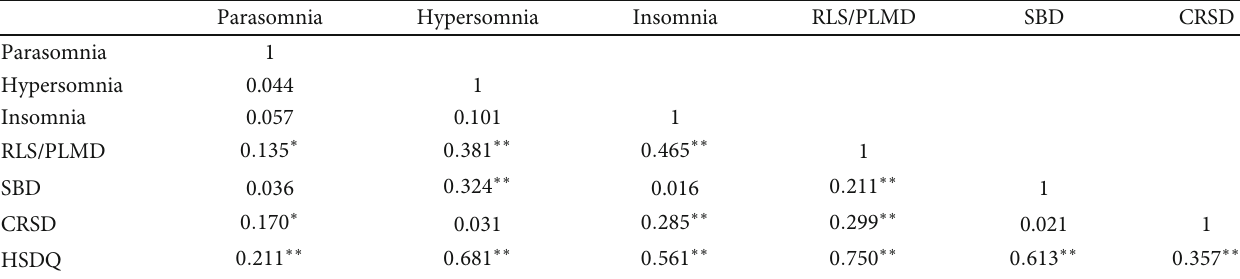
Table 7: Correlation coe ffi cient between HSDQ